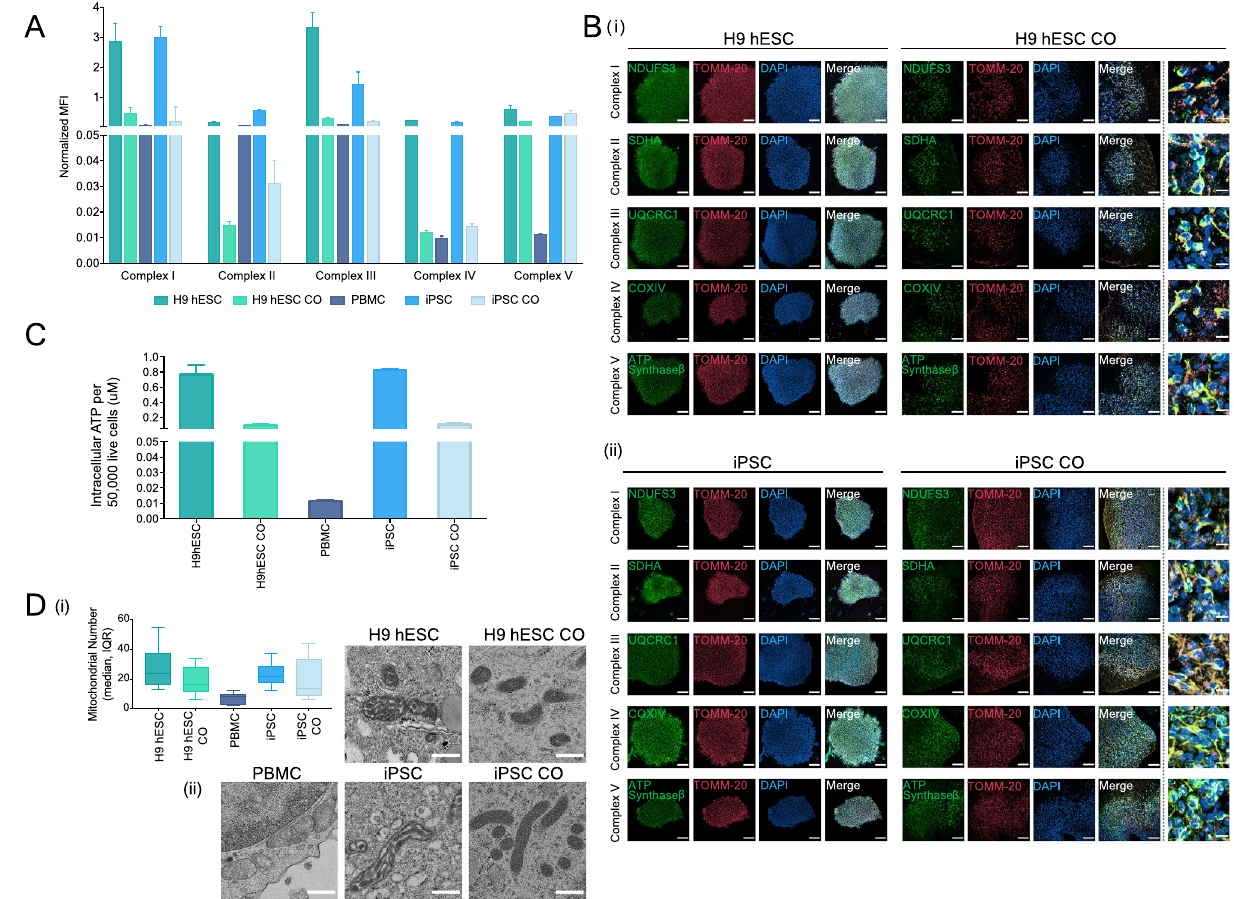
Figure 4. Mitochondrial oxidative phosphorylation and morphology throughout CO generation. ( A ) Bar graph showing the oxidative phosphorylation (OXPHOS) complexes I–V assembly levels in H9 hESCs, H9 hESC COs, PBMCs, iPSCs and iPSC COs. Median fluorescence intensities for each complex were recorded using Luminex technology. Bars, median fluorescence intensity ± SD. ( B ) Representative immunofluorescence images showing the formation of the inner mitochondrial membrane OXPHOS proteins (complex I, NDUFS3; complex II, SDHA; complex III, UQCRC1; complex IV, COXIV; complex V, ATP synthase-β; green) and the outer mitochondrial membrane (TOMM-20; red) in (i) H9 hESCs to H9 hESC COs and; (ii) iPSCs to iPSC COs. All scale bars, 100 μm. Last column shows insets, enlarged views of boxed areas from the merge CO images, all scale bars, 10 μm. In the CO tissues, out of focus light and autofluorescence of tissue matrix led to background noise which were corrected for better visualization. Brightness levels of each images were also adjusted to optimize visualization. Immunofluorescent images shown here were used for qualitative observations only—no quantitative analyses were performed. ( C ) Bar graph showing the intracellular ATP levels across H9 hESCs to H9 hESC COs and PBMCs, iPSCs to iPSC COs, bars, mean ± SD. ( D ) (i) Box plot summarizing the median number of mitochondria in 10 cells examined, boxes, median and interquartile range, IQR. (ii) Representative electron micrographs of mitochondrial morphology across H9 hESCs (scale bar, 5 μm) to H9 hESC COs (scale bar, 500 nm) and PBMCs (scale bar, 5 μm), iPSCs (scale bar, 500 nm) to iPSC COs (scale bar, 500